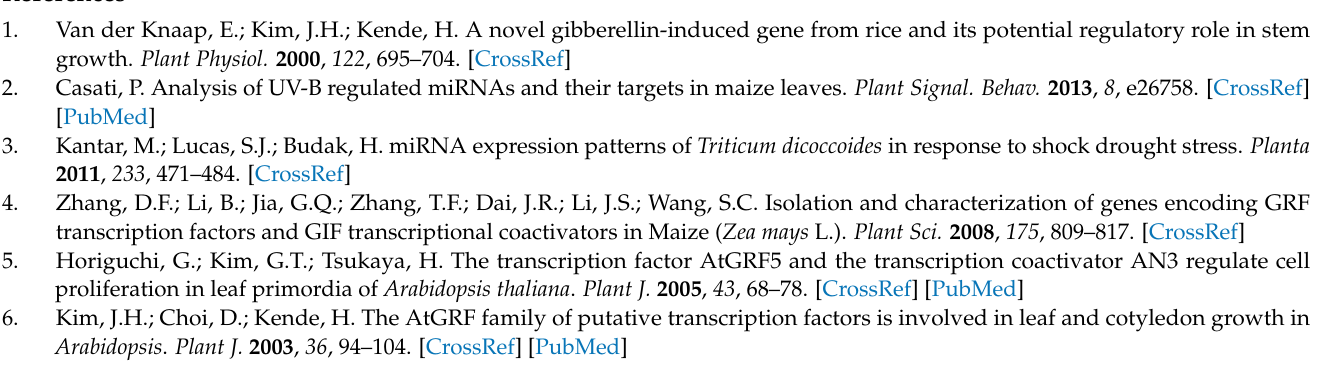
Table S1. Sequence information for all DNA oligonucleotides used in the RT-qPCR analyses presented in this